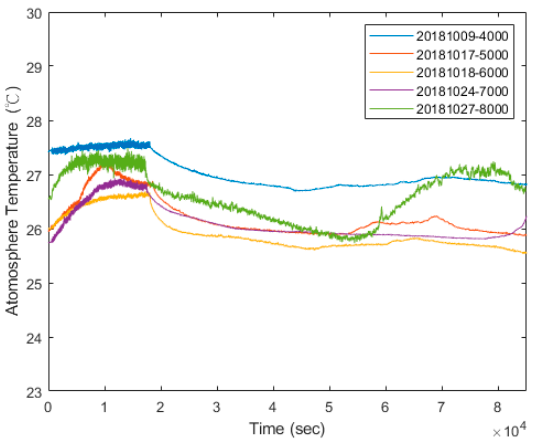
Figure 4. The photos of the experiment setup.